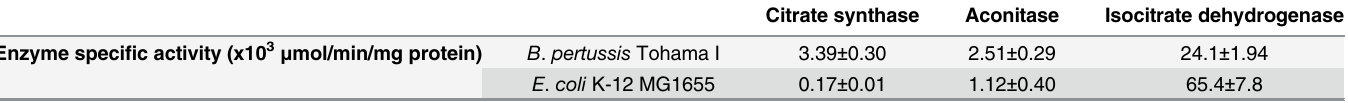
Table 5. Enzyme specific activities of citrate synthase, aconitase and isocitrate dehydrogenase in crude extract of B . pertussis Tohama I and E . coli K-12 MG1655.